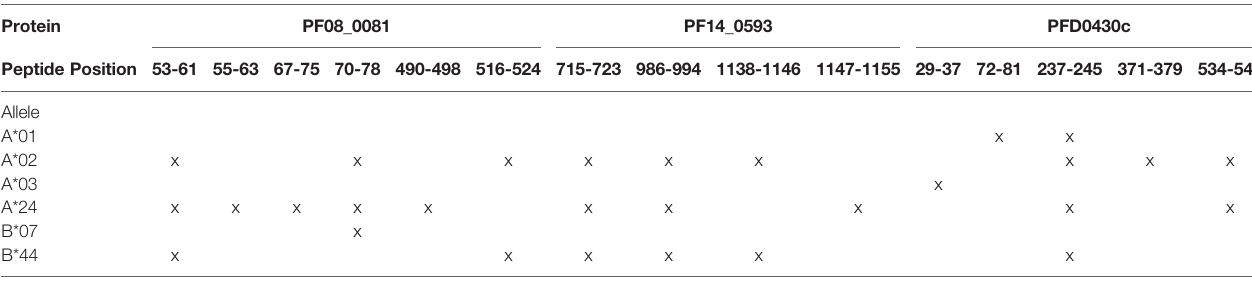
TABLE 6 | Class I peptides eliciting an immune response in three or more donors.